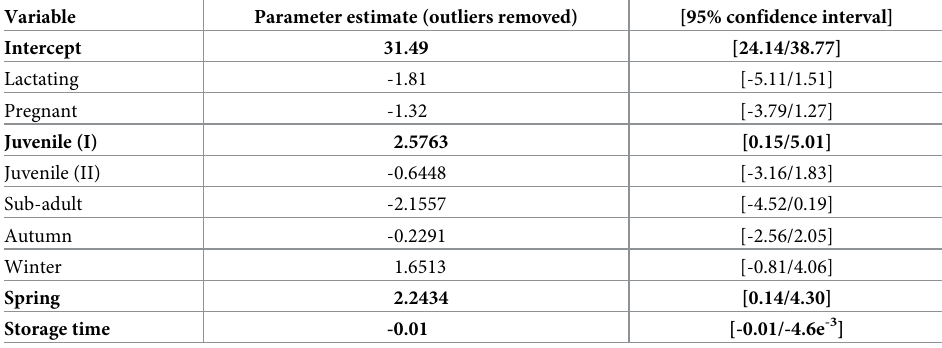
Table 3. Effects of age, season, storage time and reproductive state on hair cortisol concentration of female Egyp- tian mongoose.